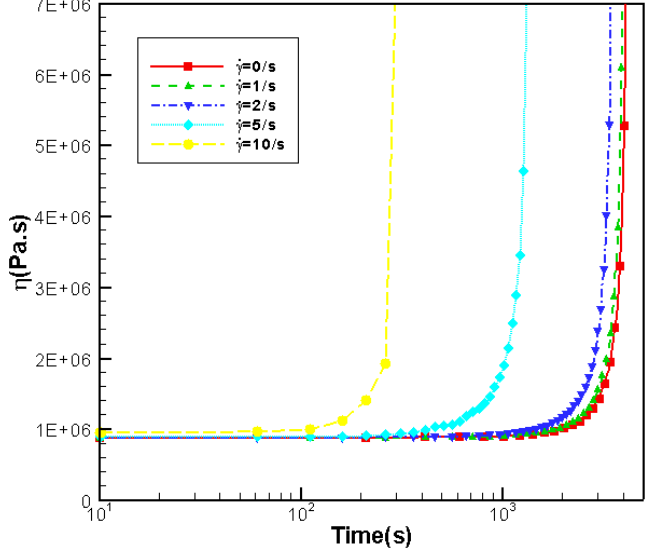
Figure 7. Evolution of viscosity with different shear rate.